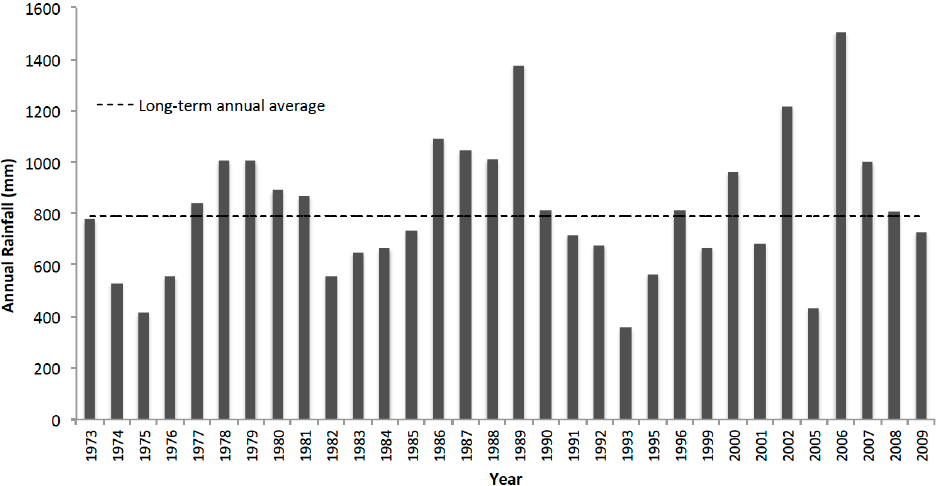
Figure 1. Annual Rainfall record at Babati station (1973–2009). Figure 2. Annual Rainfall record at Babati station